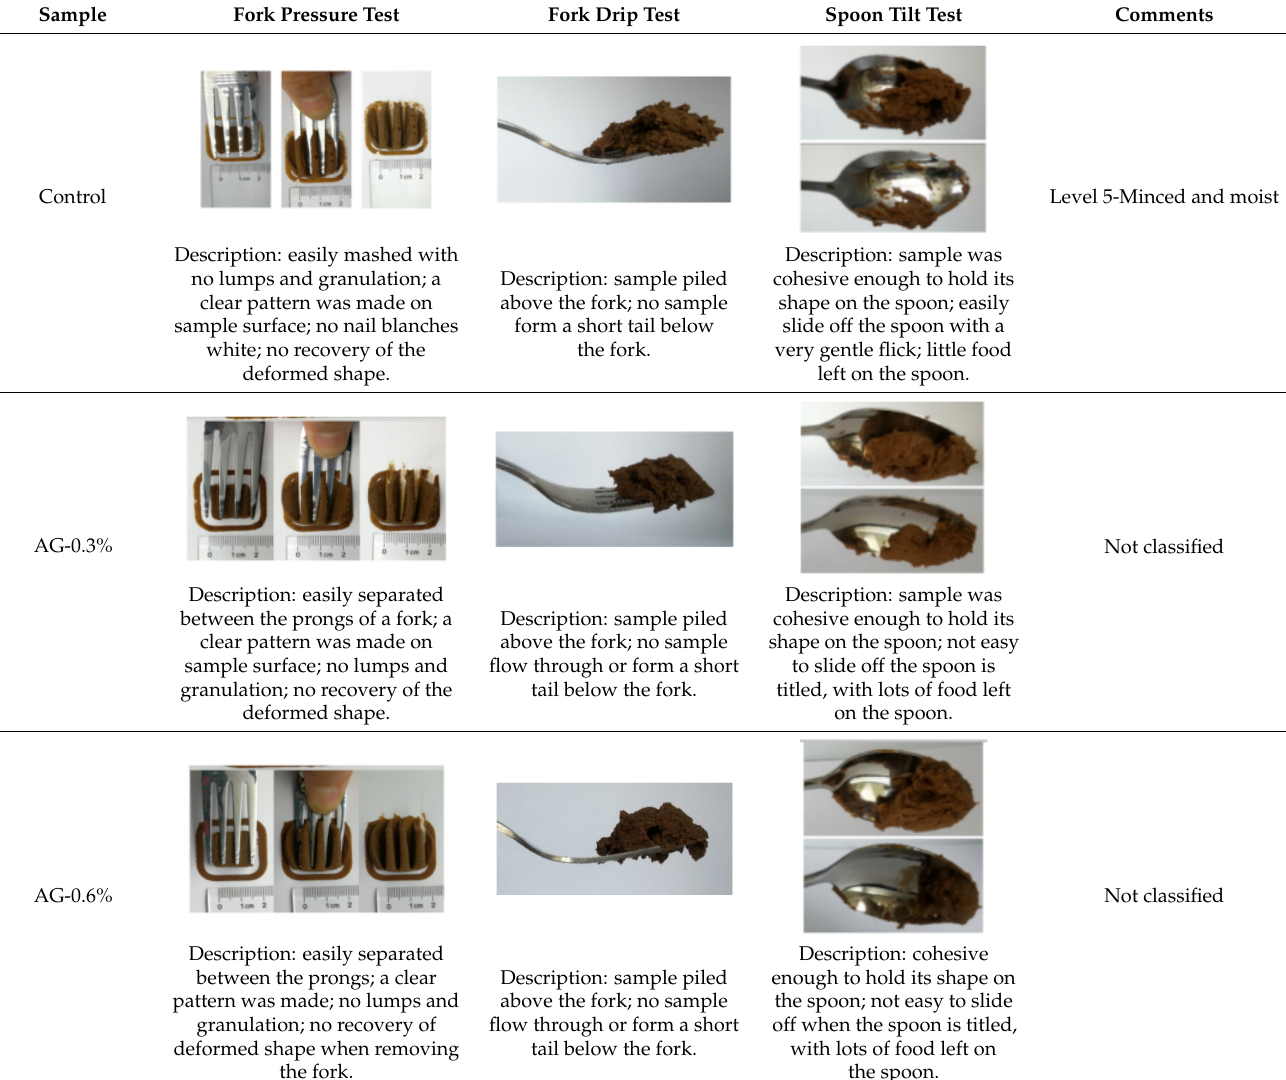
Table 3. Categorization of samples using IDDSI evaluation